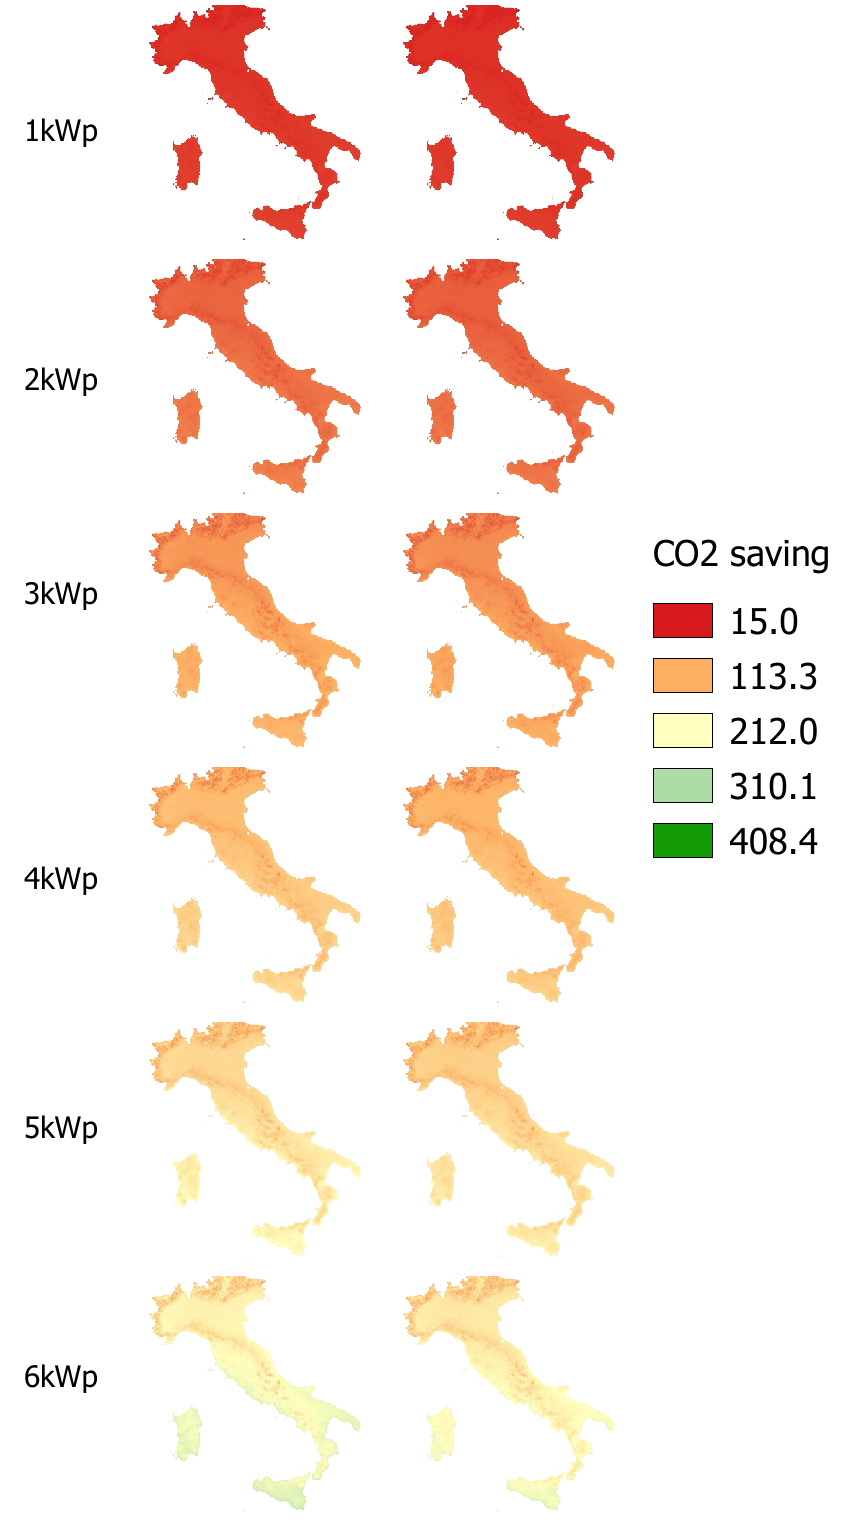
Figure A10. CO 2 saving for E L = 4000 kWh, left side without battery and right side with